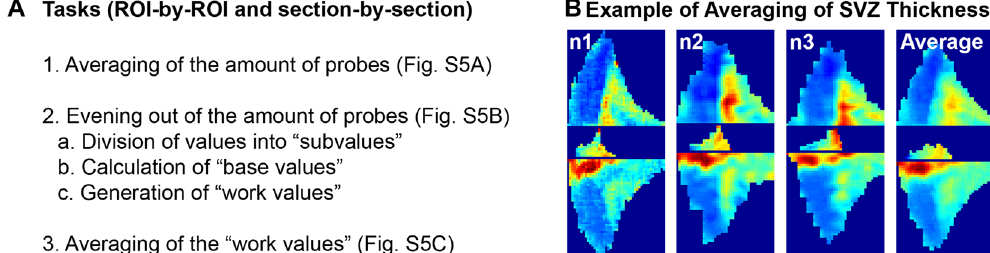
Figure 7. Averaging of different datasets using “FlashMap”. (A) List of steps performed by “FlashMap” for averaging datasets. All steps are performed ROI-by-ROI and section-by-section. In a first step the amount of probes is averaged (1), which allows to even out the amount of probes by dividing the values into ‘subvalues” (2a) to calculate “base values” (2b) and generate “work values” (2c). Finally, the new “work values” are averaged by “FlashMap” (3). (B) Heatmaps represent the relative SVZ thickness of 3 independent analyses (n1, n2, n3) as well as an averaged heatmap generated by “FlashMap”. Abbreviation: ROI, region of interest; SVZ, subventricular zone. For a more detailed illustration see also Supplementary Fig.